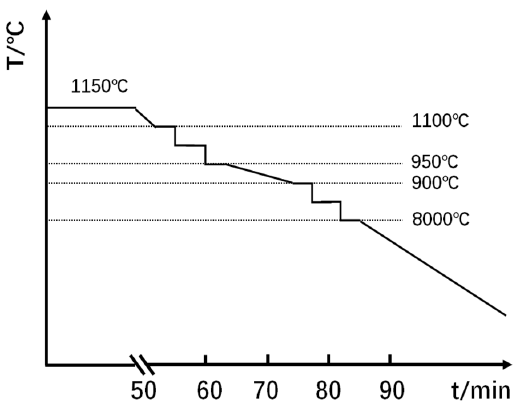
Figure 1. Schematic of controlled rolling schedule.